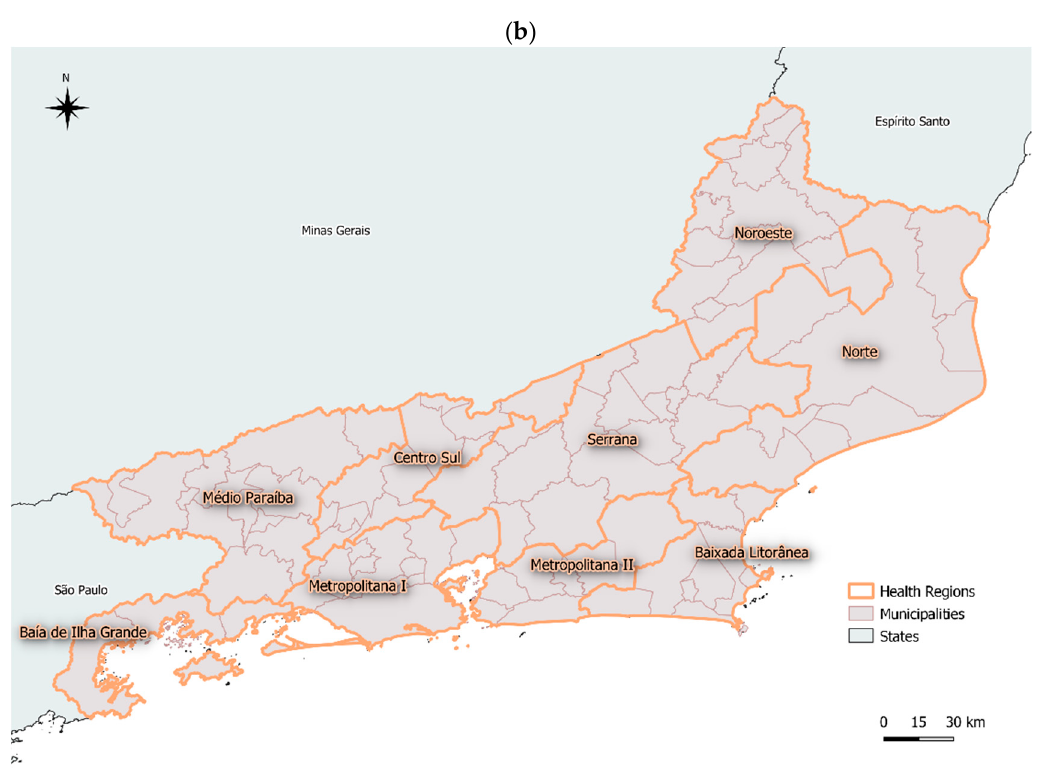
Figure 1. Map of the Rio de Janeiro state and its municipalities ( a ) and nine health regions ( b ). Source: Own elaboration.